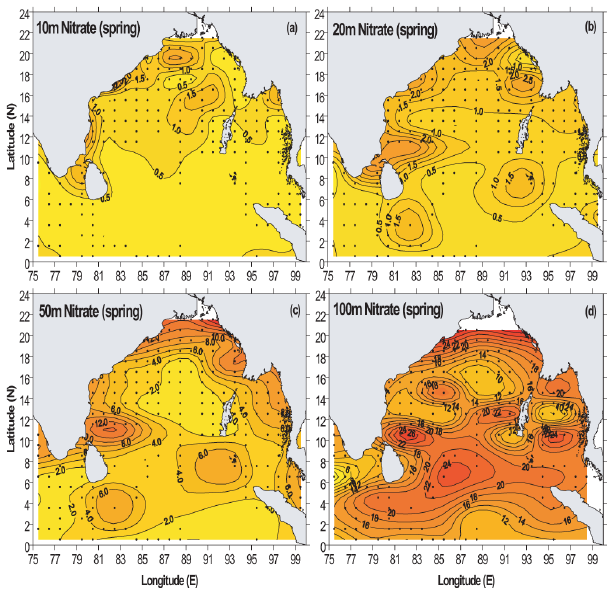
Figure 10. Spatial distribution of nitrate (µM) at (a) 10, (b) 20, (c) 50, and (d) 100m during spring intermonsoon. Note the change in contour interval in (c) and (d)